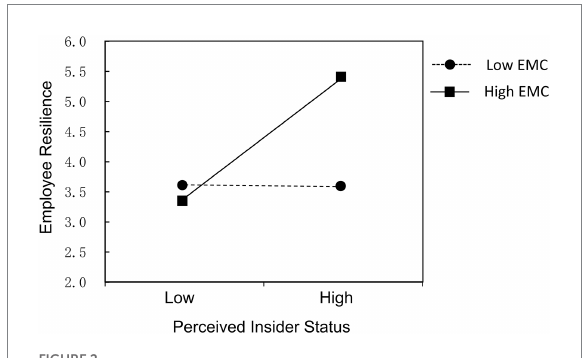
FIGURE 2 Moderating role of EMC on the relationship between perceived insider status and employee